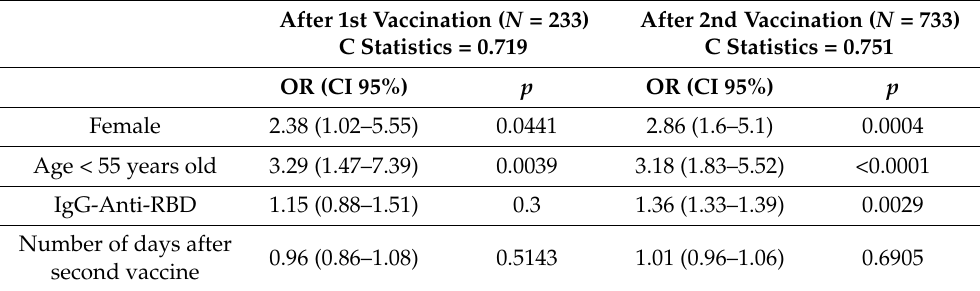
Table 5. Factors associated with adverse events following 1st and 2nd vaccination doses using multivariate logistic regression analysis. After 1st Vaccination ( N = 233) After 2nd Vaccination ( N = C Statistics = 0.719